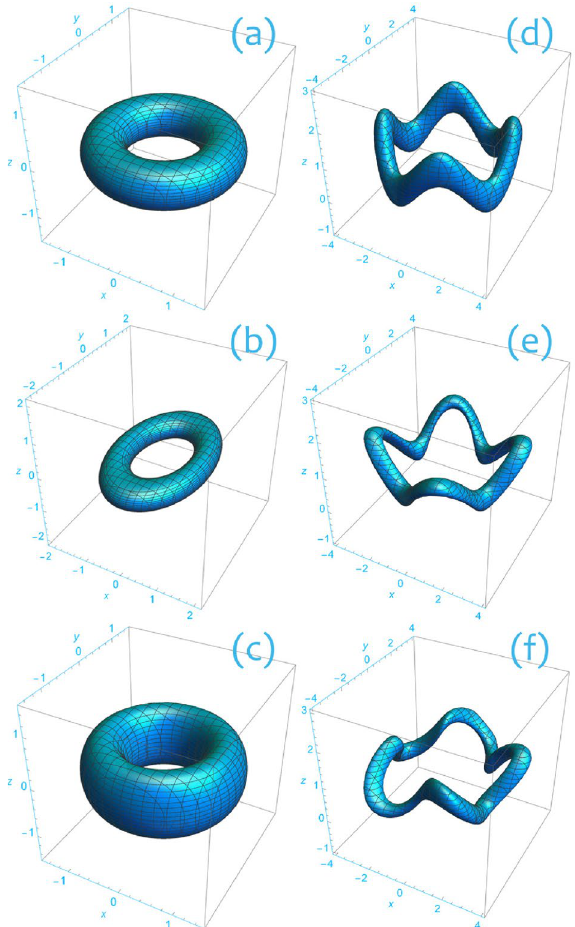
Figure 2. Toroidal surfaces obtained as level sets of the function (cid:31) defined by Eq. (6). ( a ) Axially symmetric torus (cid:31) = 0.15 with µ = r , µ 0 = 1 , E = 1 , and h = 0 . ( b ) Elliptic torus (cid:31) = 0.1 with µ = (cid:31) x 2 + 0.4 y 2 , µ 0 = 1 , E = 1 , and h = 0 . Notice that sections z = constant form ellipses. ( c ) Axially symmetric torus (cid:31) = 0.15 with µ = r , µ 0 = 1 , E = 0.4 , and h = 0 . Notice that sections ϕ = constant form ellipses. ( d ) Torus (cid:31) = 0.1 with µ = r , µ 0 = 3 , E = 1 , and h = 1 + 0.5sin ( 4 ϕ) . ( e ) Torus (cid:31) = 0.1 with µ = r , µ 0 = 3 + 0.5sin ( 4 ϕ) , E = 5 + 2.5sin ( 4 ϕ) , and h = 1 + 0.5sin ( 4 ϕ) . ( f ) Torus (cid:31) = 0.1 with µ = (cid:31) x 2 + ( 0.9 + 0.1sin ( 3 ϕ)) y 2 , µ 0 = 3 + 0.5sin ( 5 ϕ) , E = 5 + 2.5cos ( 3 ϕ) , and h = 1 + 0.5sin ( 4 ϕ) . Figure created using